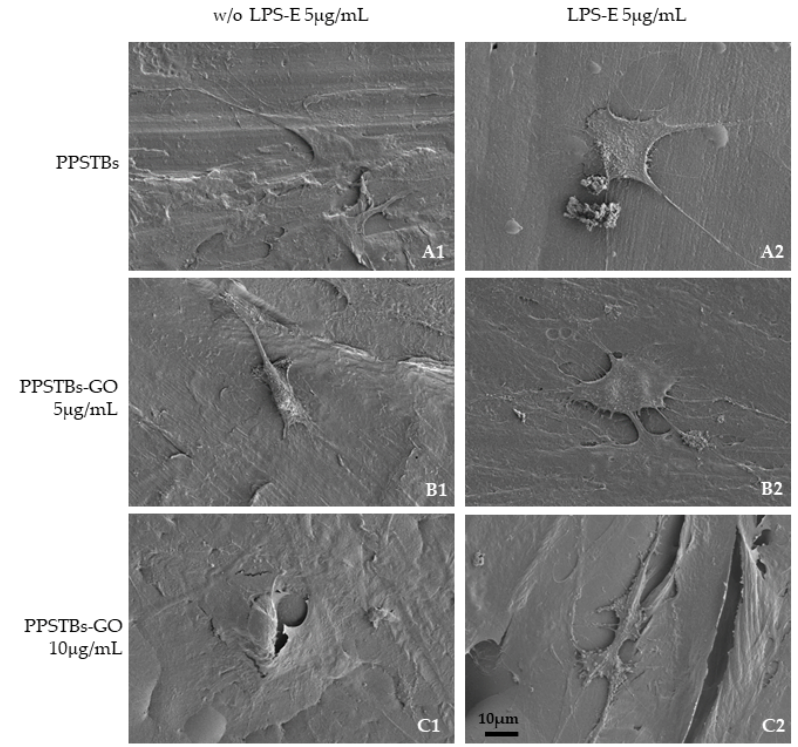
Figure 4. ( A1 – C1 ) Representative SEM images of hGFs, cultured for 24 h on PPSTBs, PPSTBs ‐ GO 5 μ g/mL, and PPSTBs ‐ GO 10 μ g/mL in the absence of LPS ‐ E treatment. ( A2 – C2 ) hGFs, cultured for 24 h on PPSTBs, PPSTBs ‐ GO 5 μ g/mL, and PPSTBs ‐ GO 10 μ g/mL with LPS ‐ E. hGFs developed abundant filopodia favoring attachment to the surface and revealing that cells grow in the presence of LPS ‐ E and with different concentrations of GO. Scale bar 10 μ m.